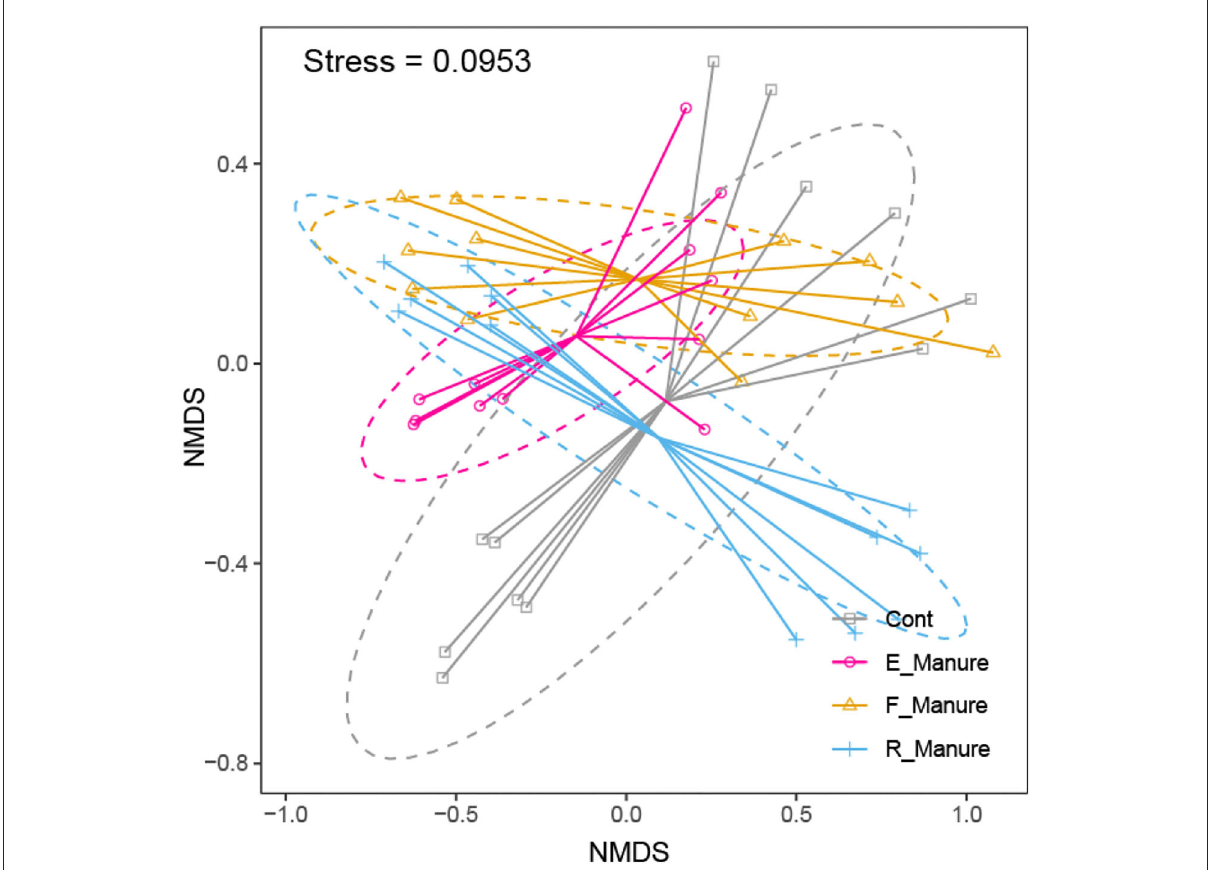
FIGURE1 Non-metric multidimensional scaling (NMDS) ordination of bacterial communities. PERMANOVA shows that fertilization effects are the strongest, contributing the largest components of variation to the overall model ( p = 0.001 <